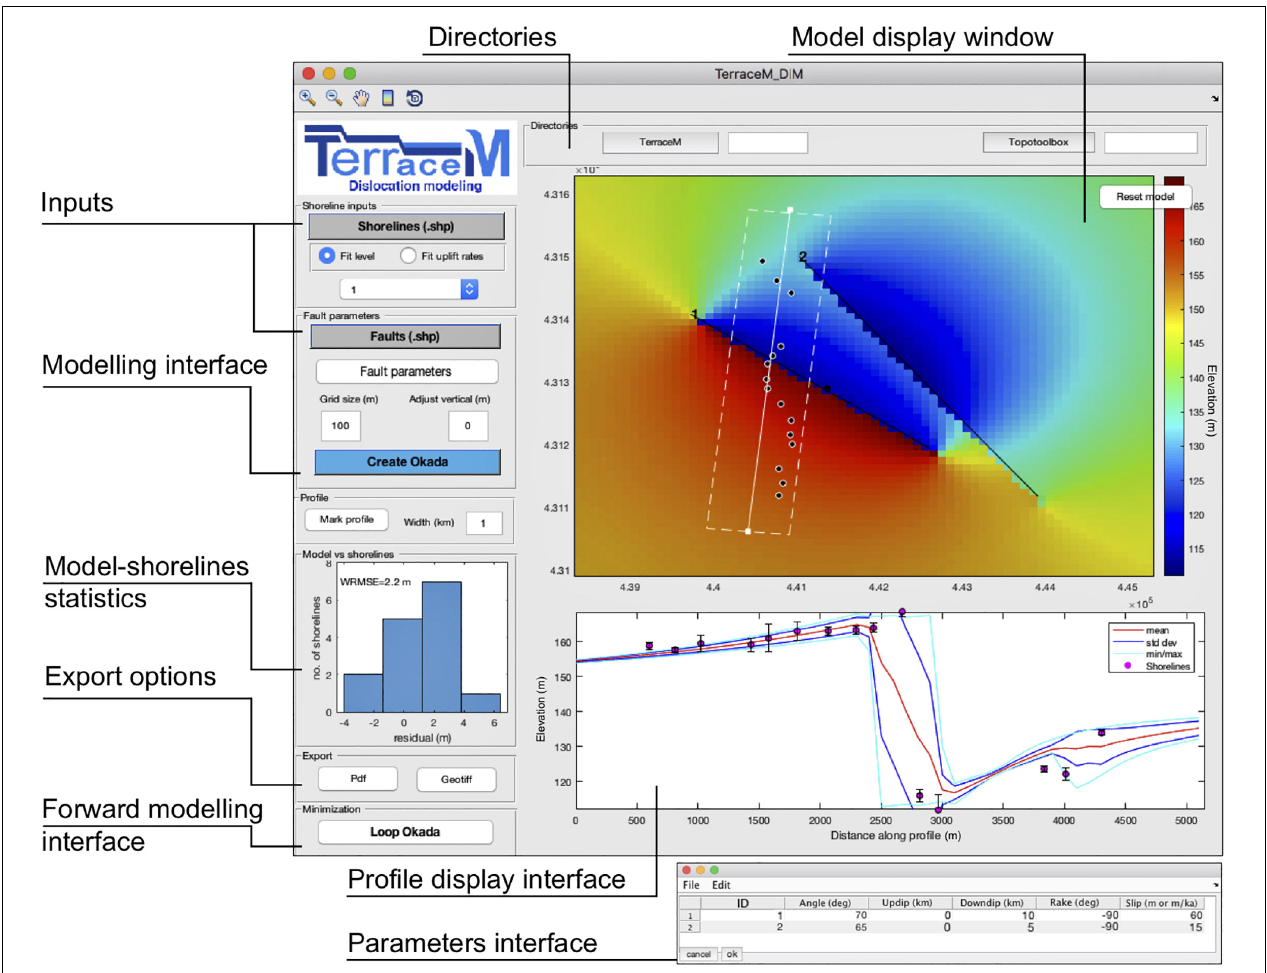
FIGURE 7 | Dislocation Model (DIM)